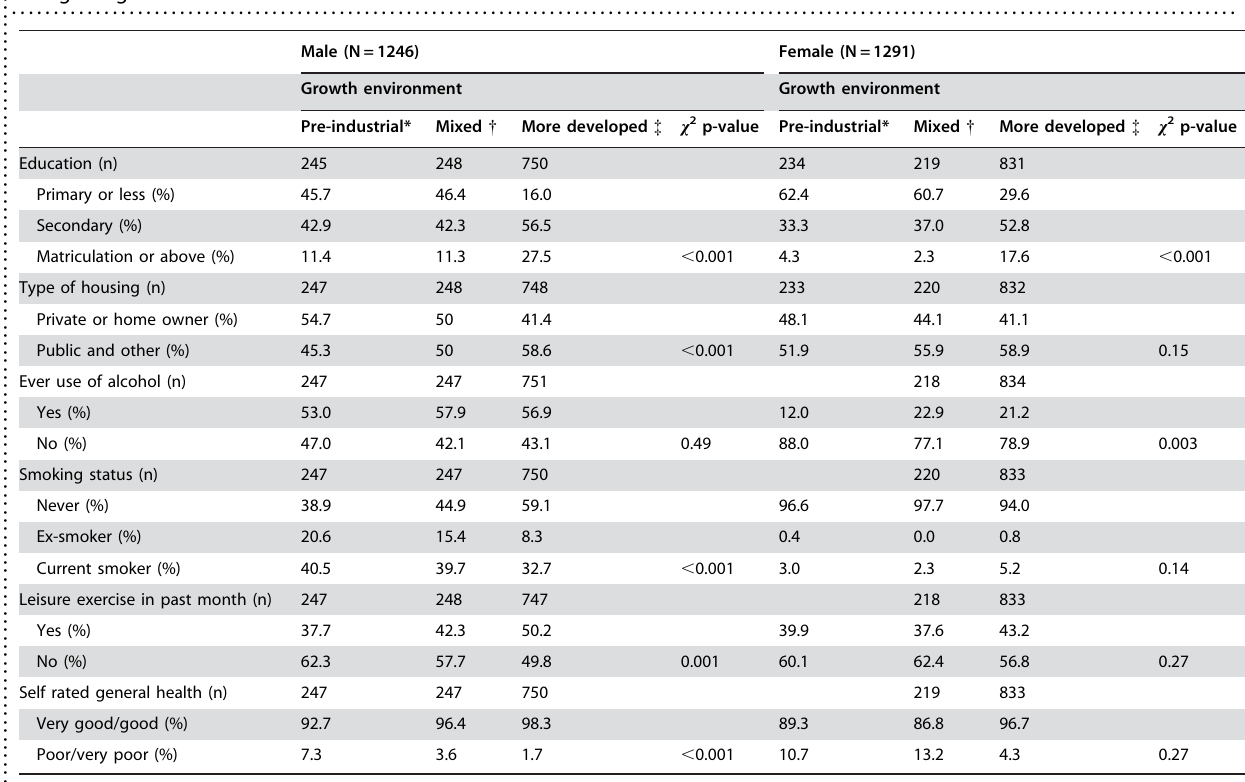
Table 1. Characteristics by sex and growth environment for 2357 Hong Kong residents born in Guangdong province (China)